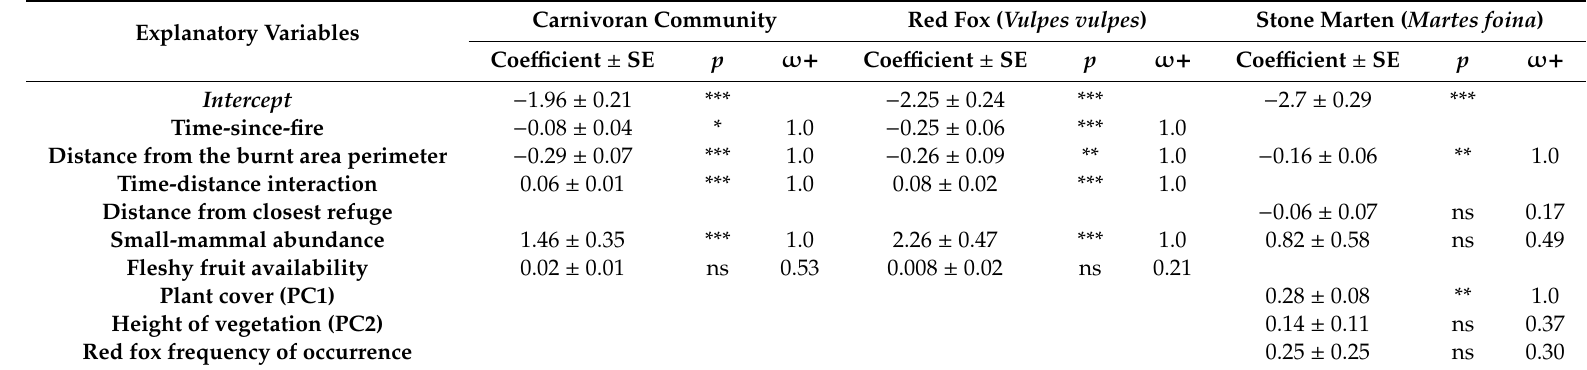
Table 2. E ff ect of environmental variables on carnivoran frequency of